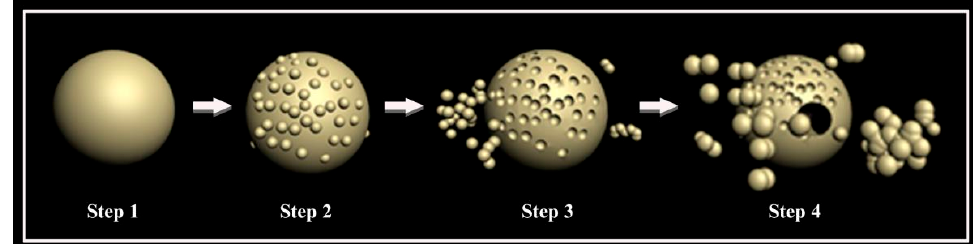
Figure 7. Prediction diagram of the BiVO 4 generation mechanism.